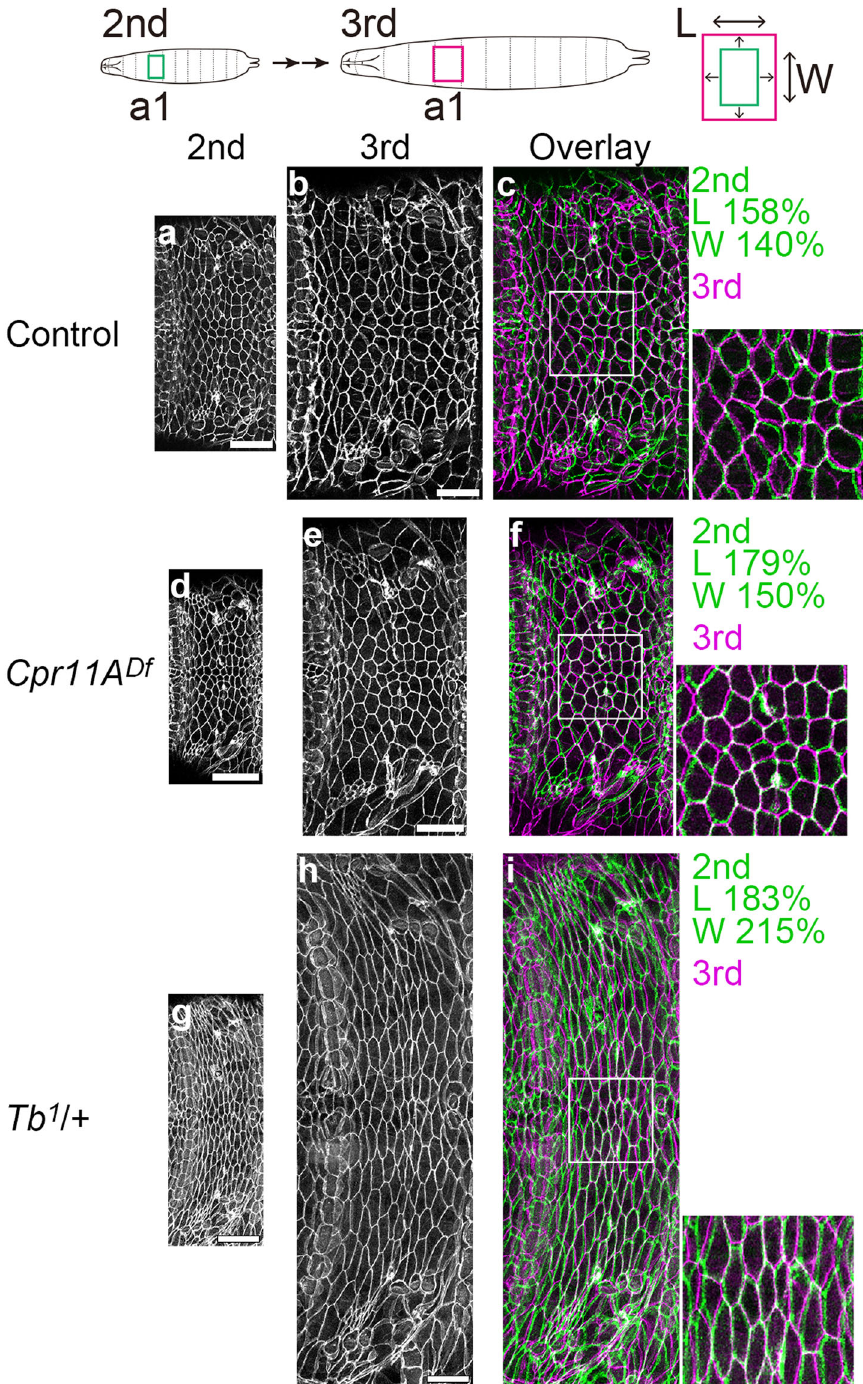
Fig. 7 Epidermal cell outlines during larval growth. Cell-cell boundaries in the epidermis, marked by Nrg:GFP, on the dorsal side of the abdominal segment 1 (a1) of the control ( a , b ), Cpr11A Df ( d , e ) and Tb 1 / + ( g , h ) larvae at the second instar ( a , d , g ) and two days later at the third instar ( b , e , h ). In c , f and i , the third instar images shown in magenta are overlaid on the second instar images enlarged along the body length (L) and width (W) by the indicated percentages and shown in green. Magni fi cations of the boxed regions are shown on the right. Bars, 50 μ